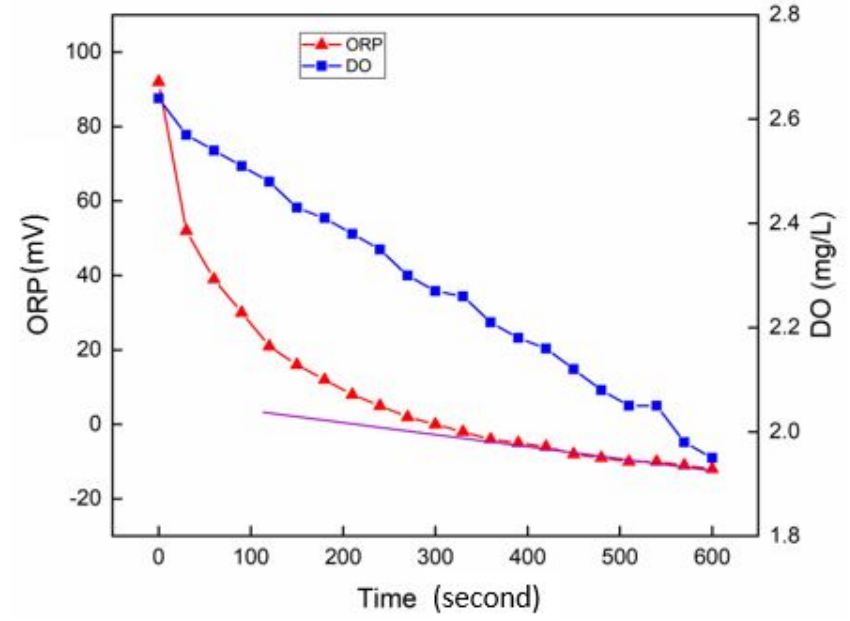
Figure 5. The DO and ORP profiles of during a test submerging the sensors into raw wastewater. The blue curve is the DO profile, and the red curve represents the ORP variation during denitrification. The purple line is the tangent to the ORP curve at 600th second.